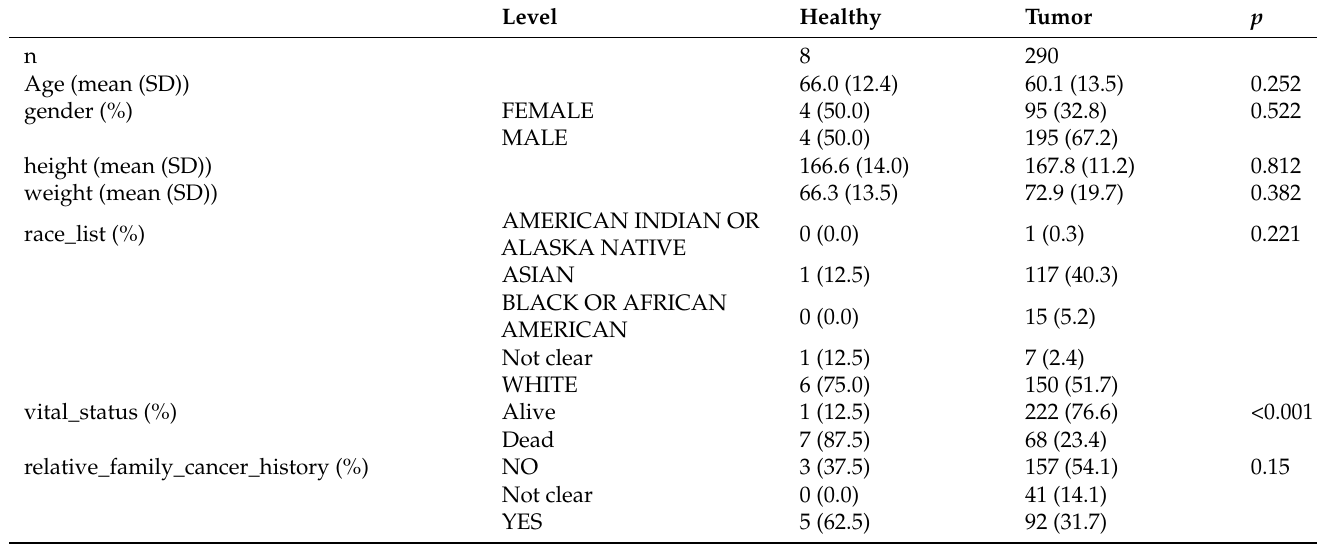
Table 4. Patients back ground for